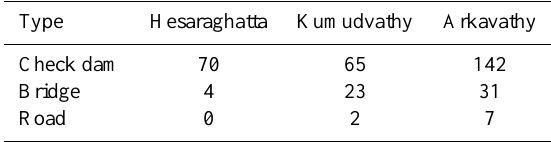
Table 2. Number and type of stream encroachments in each section TG Halli catchment source: Zoomin Tech Report to CNNL,